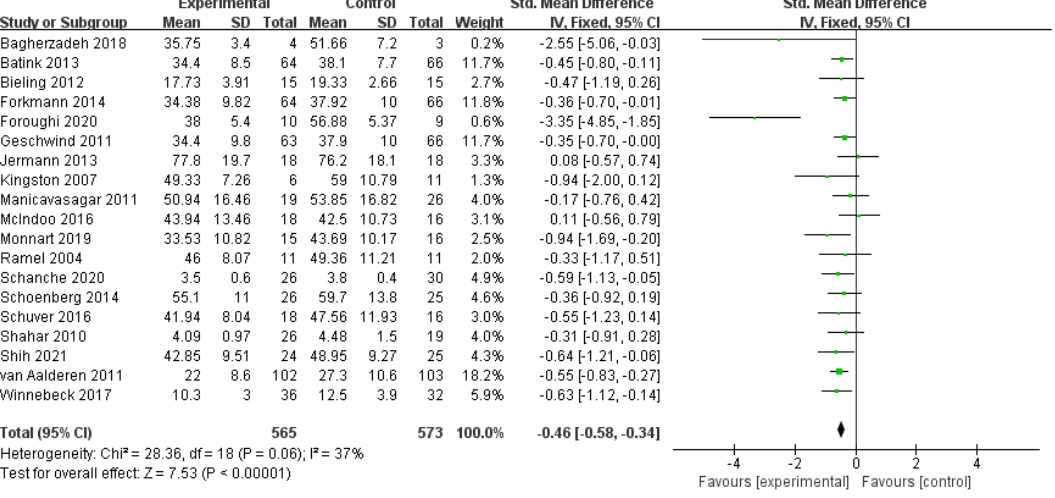
Figure 3. Meta − analyses of the effects of MBIs on rumination [30–48].